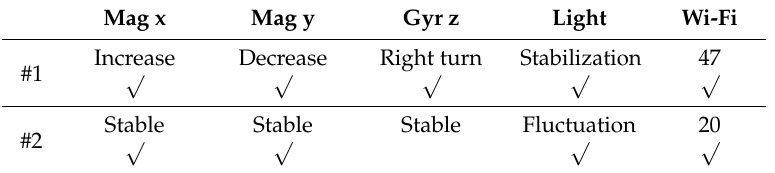
Figure 9. Co-existing relationship of sensor data. Table 1. An example of the co-existing relationships of sensors in a subset of framework.